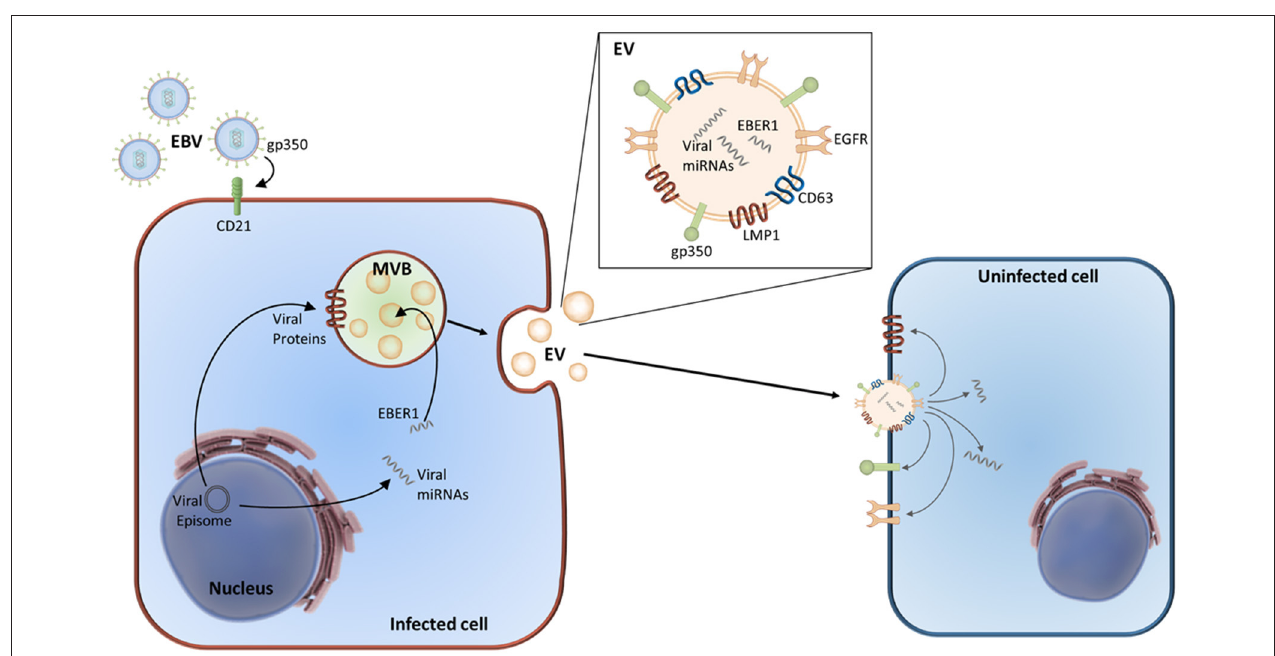
FIGURE 2 | Exosome remodeling by EBV. EBV enters in the cell via the recognition of gp350 by the CD21 receptor. EBV-infected cells produce exosomes enriched for LMP1, gp350, and EGFR. Alongside cellular RNAs, these exosomes also contain viral RNAs, miRNAs, and proteins. Following the release of these EBV-modified exosomes, they can enter uninfected cells where their cargo can be incorporated into the recipient cell and start their mechanism of action.